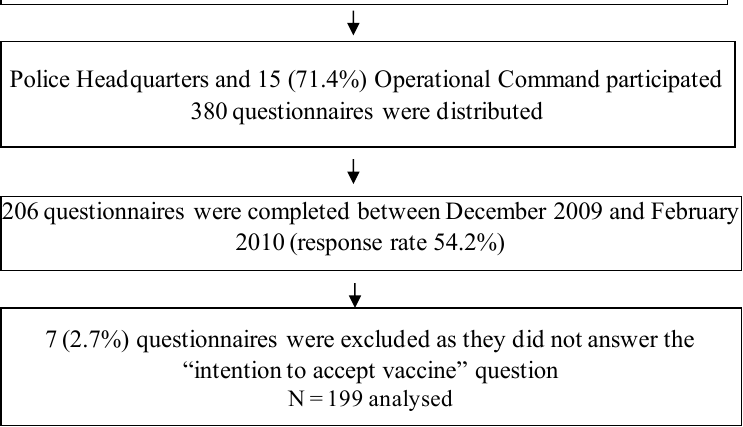
Figure 1. Flow chart illustrating response to questionnaire.